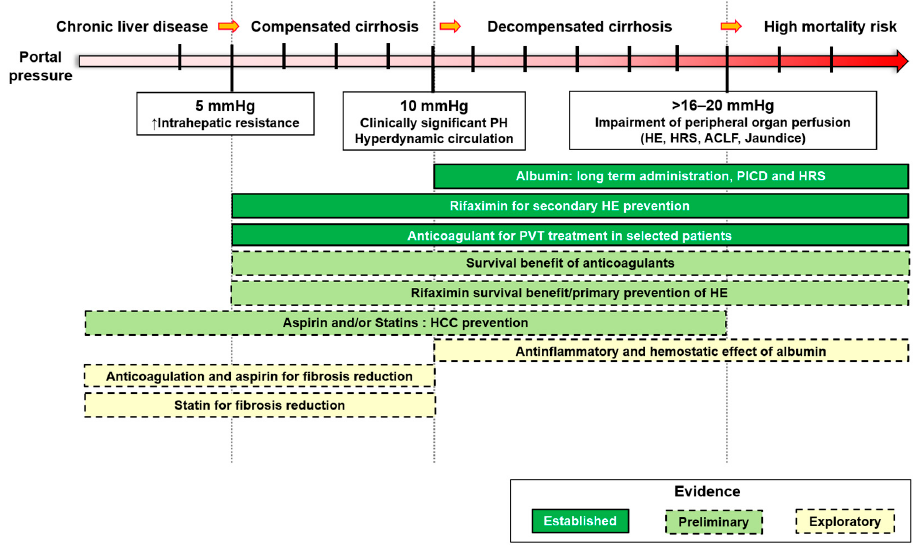
Figure 1. Non-etiological therapies, in relation to portal hypertension level and grade of evidence. PICD, paracentesis induced circulatory dysfunction; HE, hepatic encephalopathy; HRS, hepatore- nal syndrome; ACLF, acute on chronic liver failure; HCC, hepatocellular carcinoma; PVT, portal vein